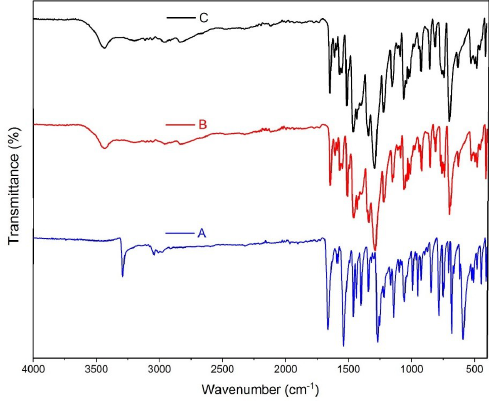
Figure 4. FT­IR spectra of ( A ) HL, ( B ) single crystals of 1 , and ( C ) nanoparticles of 1 .